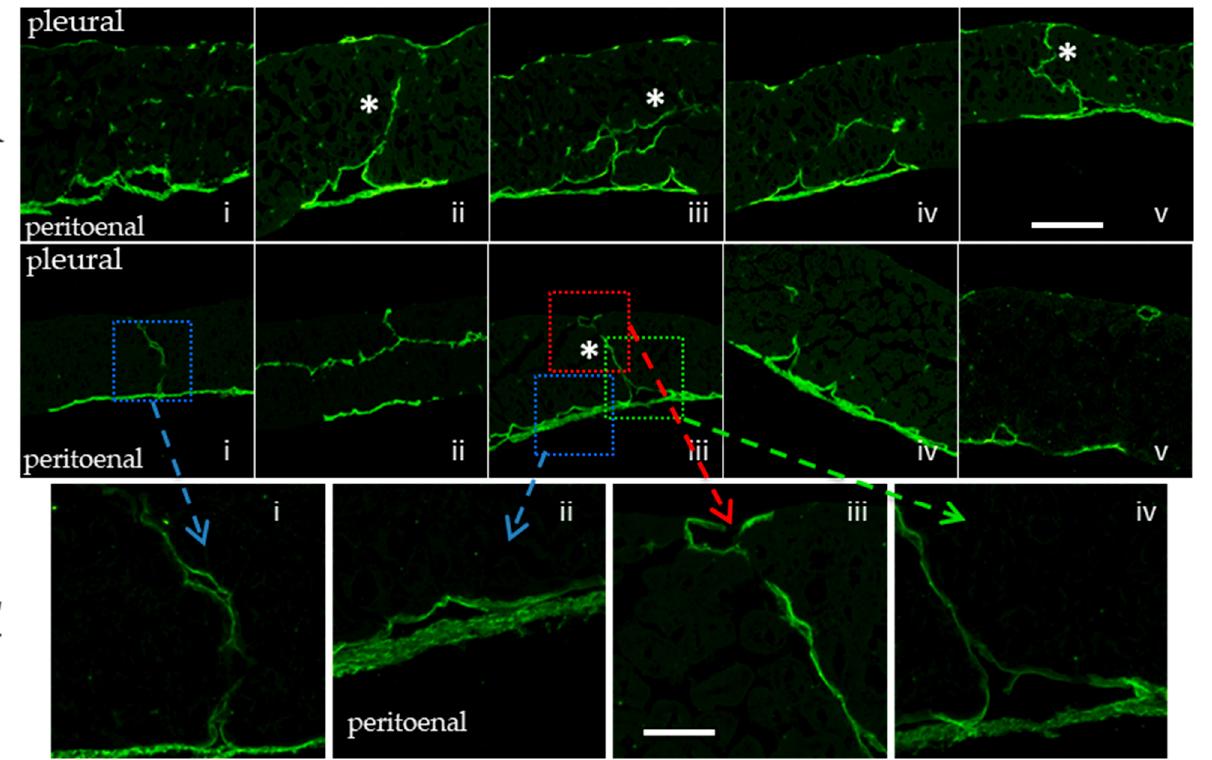
Figure 3. Panels ( A , B ). Low magnification confocal images of LYVE 1 stained mouse diaphragm. The pleural and peritoneal sides of the diaphragm (top and the bottom of panels ( A )i–v) may be connected by pleuro-peritoneal lymphatic vessels (asterisks). A different mouse cross section is shown in the image sequence ( B )i–iv whose details are enlarged in panels ( C )i-iv. Bar: 150 µm. Bar: 100 µm.